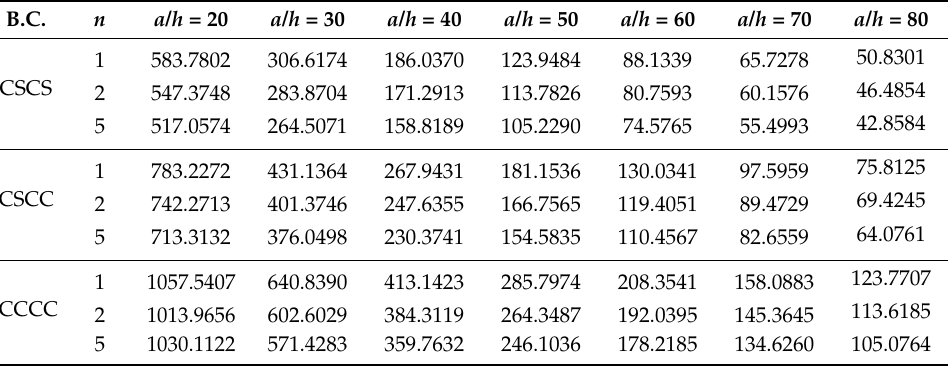
Table 8. Critical buckling temperature ∆ T cr of type-I FGM rectangular thin plate with different a / h and various B.C. under a uniform temperature field ( a / b = 2, T 0 = 300 K). B.C.